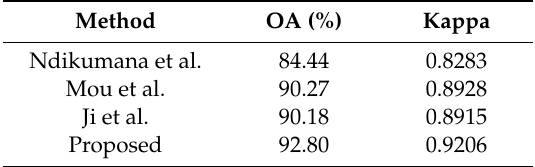
Table 9. Comparison with other deep learning